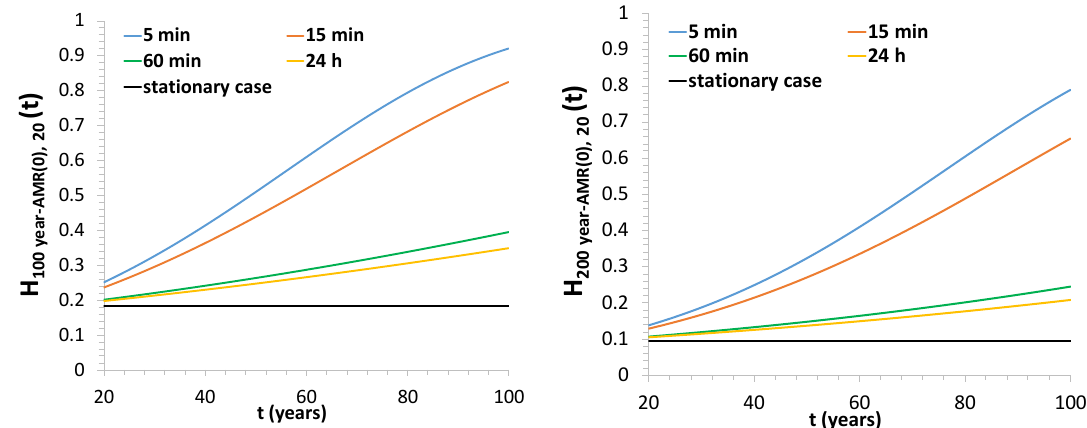
Figure 9. Temporal variation of Hazard related to the 100-year ( left ) and 200-year ( right ) AMR quantiles of the stationary process.